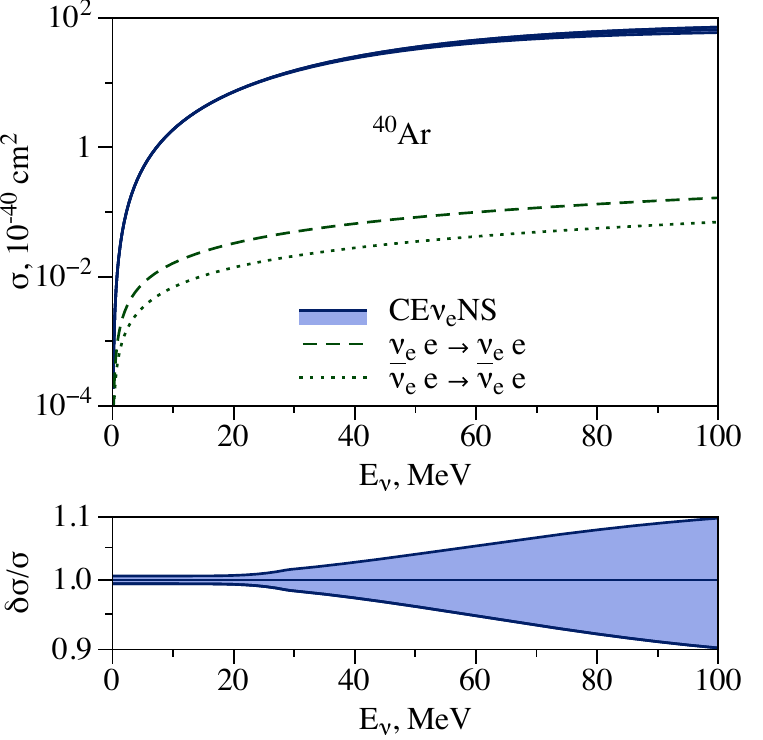
Figure 6 . On the upper plot, CE ν e NS cross section on 40 Ar (blue band) is compared to ν e e and ¯ ν cross sections of [118] multiplied by the factor Z = 18 . On the lower plot, the relative error of e e the total CE ν NS cross section is e